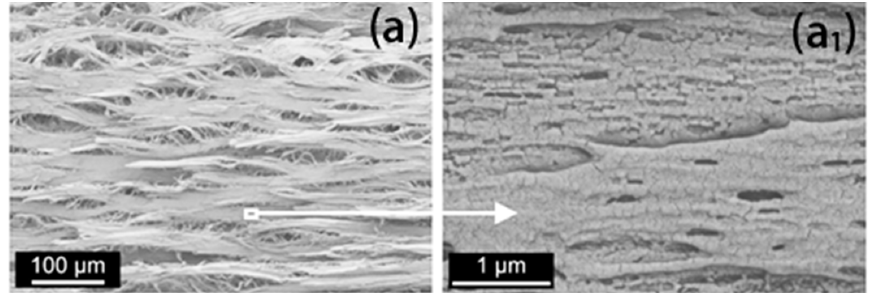
Figure 10. Typical PLA crystal structure: ( a ) crystal obtained by cold crystallization at 120 °C; ( b ) directional crystal structure formed by pressure induced flow; ( a 1 , b 1 ) are local enlarged images of the corresponding crystal. FD: flow direction, LD: load direction (reproduced with permission from Reference [65], Copyright 2022 Elsevier).